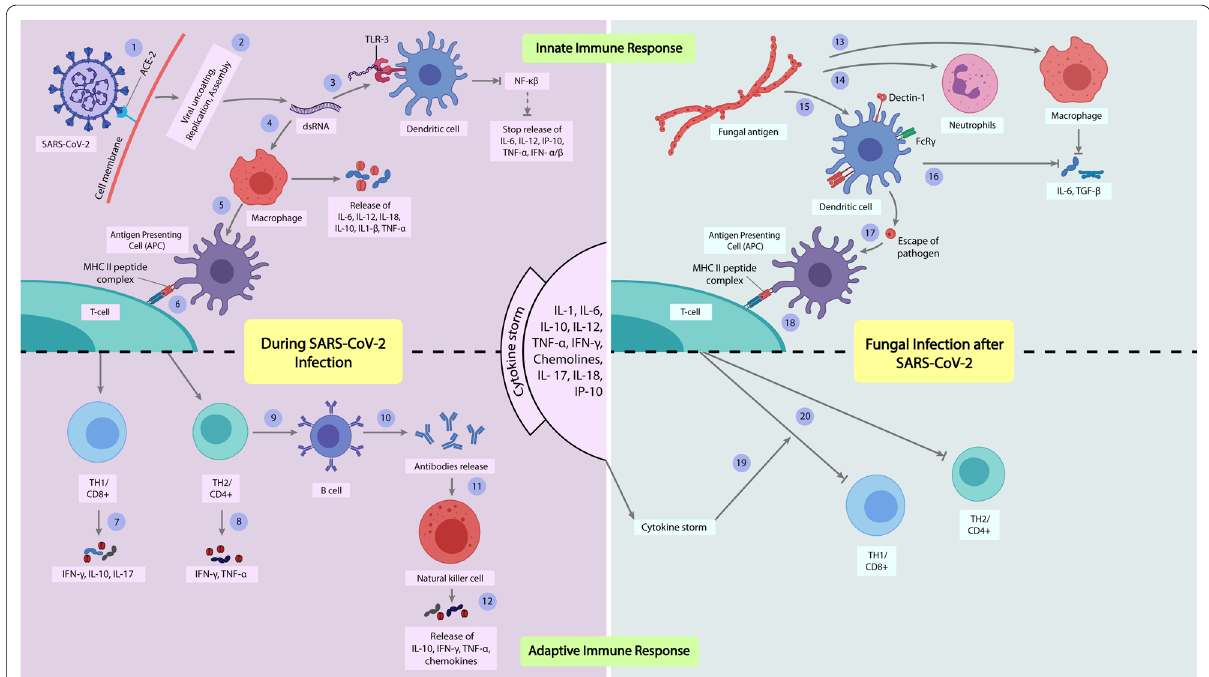
Fig. 1 An overview of how fungi take the chances of the hampered immune system caused by SARS-CoV-2. Innate immune response in SARS-CoV-2 infection: SARS-CoV-2 enter the host cell through the attachment of viral spike (S) protein to ACE-2 (angiotensin-converting enzyme-2) receptor on the cell membrane (1) . Then ssRNA virus is reassembled to the dsRNA viral genome (2) . TLR-3 (Toll-like receptor-3) mutation stops the NF-κβ (nuclear factor kappa-light-chain-enhancer of activated B cells) pathway and prevents the release of cytokines and chemokines (3) . Macrophage releases IL-6, IL-10, IL-12, IL-18, IL1-β, and TNF-α (4) . Antigen-presenting cells (APC) present MHC II (major histocompatibility complex II) peptide complex on T cells (5, 6) . Adaptive immune response in SARS-CoV-2 infection : TH1/CD8 TNF-α, IL-10, and IL-17 (7, 8) . TH2 releases antibodies followed by activating B-cell (9, 10) . Antibodies activate NK (natural killer) cells to release cytokines and chemokines (11, 12 ). Innate immune response in fungal infection after SARS-CoV-2 infection : Fungal complement protein stops the release of IL-6 and TGF-β (13) . Fungal pathogens activate neutrophils (14) . Pathogen attaches by dectin-1 in dendritic cells, and destructed immune system fails to release cytokines (15, 16) . Pathogen escapes and subsequently presents on APC (antigen-presenting cells) with the help of the MHC II peptide complex to activate T cells (17, 18) . Adaptive immune response in fungal infection after SARS-CoV-2 infection: Impaired adaptive immune response having cytokines from the “cytokine storm” results in the blockage of the proliferation of T cell into TH1/CD8 CD4 (19, +